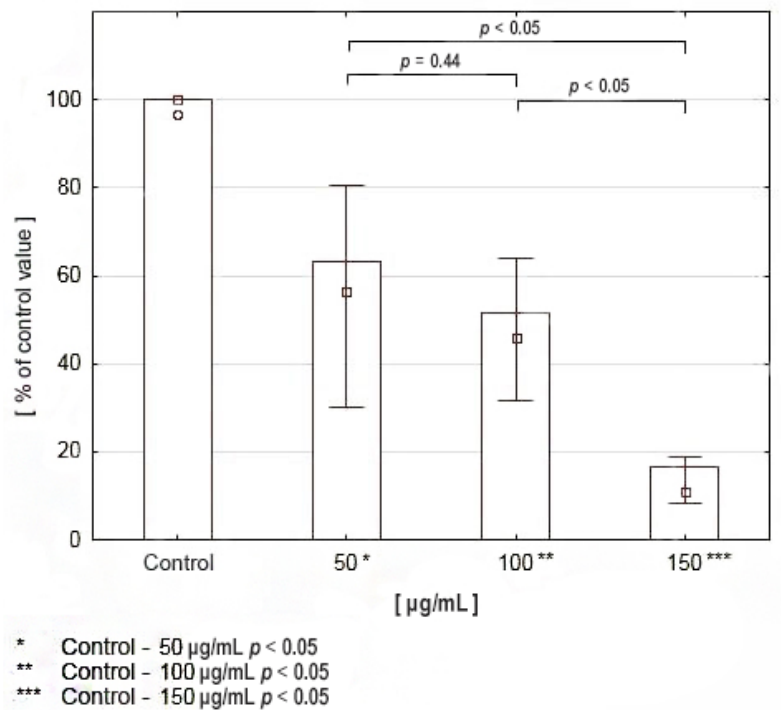
Figure 5. DNA biosynthesis in CAL-27 cell culture treated with various concentrations of celecoxib. Cancers 2020 , 12 , x